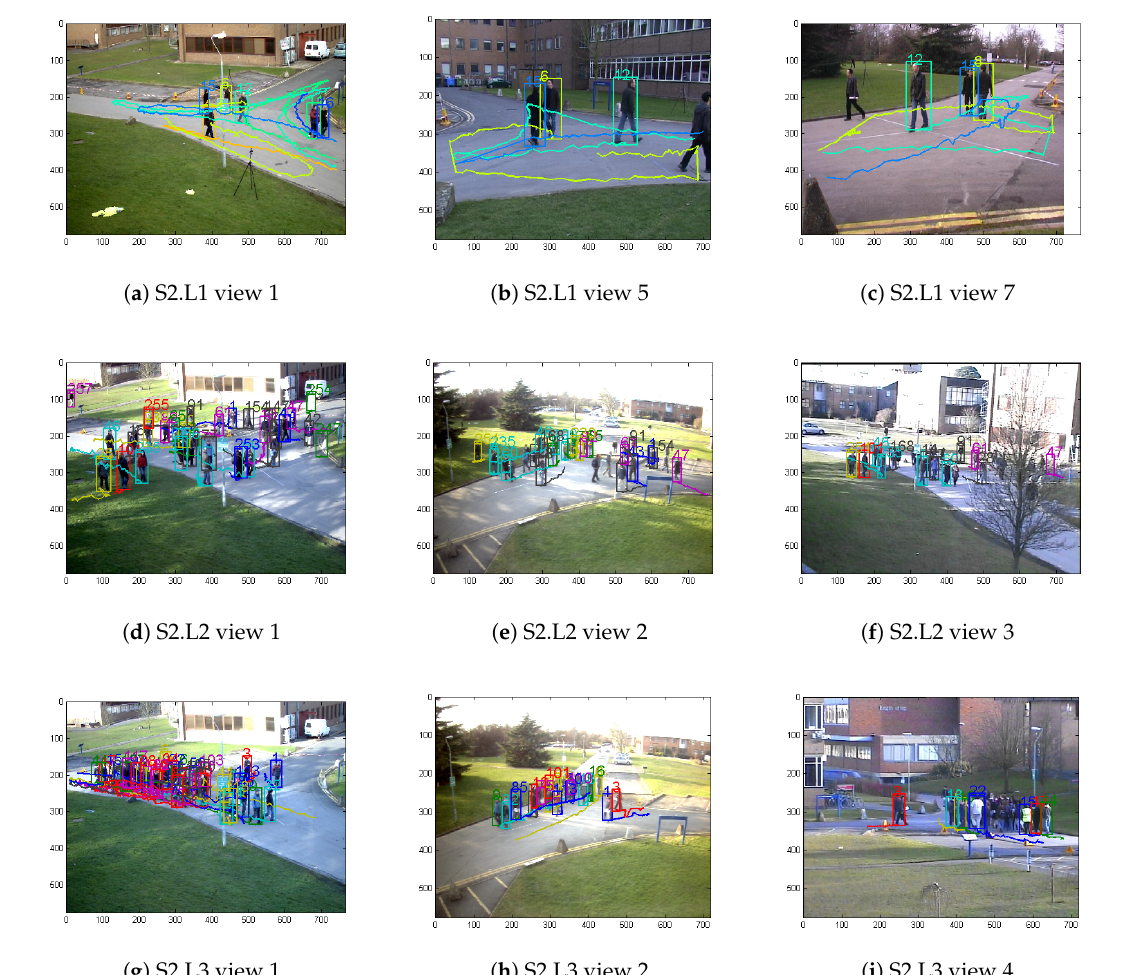
Figure 10. Tracking results. Panels ( a – c ) display the tracking results of the first to the 350th frame of the first, fifth, and seventh views in PETS2009 S2.L1, respectively. Panels ( d – f ) display the tracking results of the first to the 51st frame of the first, second, and third views in PETS2009 S2.L2, respectively. Panels ( g – i ) display the tracking results of the 160th to the 210th frame of the first, second, and fourth views in PETS2009 S2.L3,